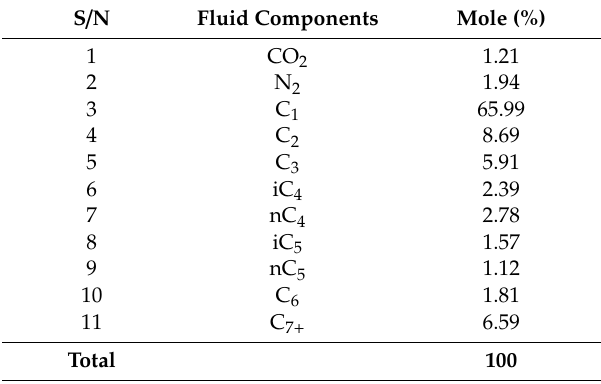
Table 2. Fluid Components and their respective composition in moles, Kenyon and Behie 1987